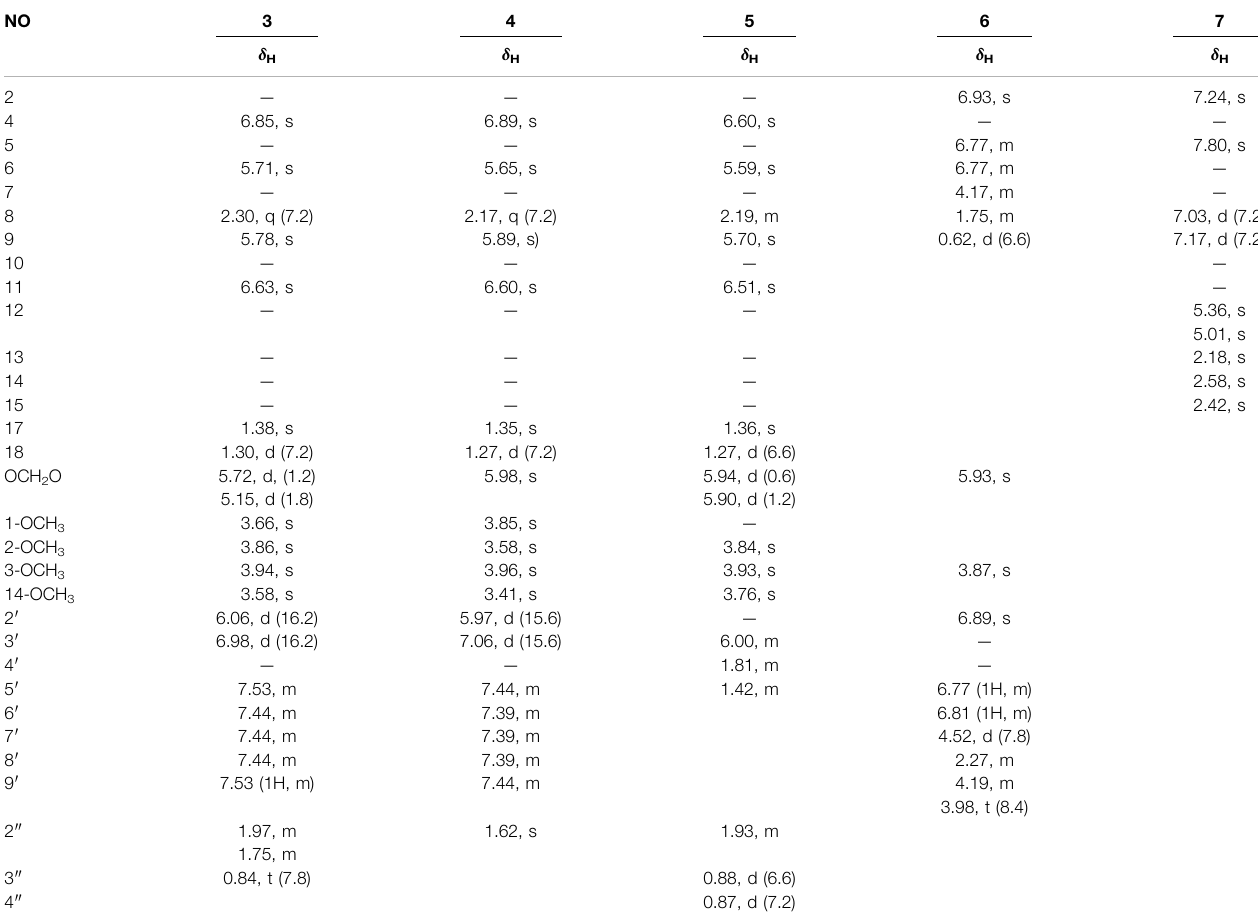
TABLE 2 | ｜ 1 H NMR (600 MHz) data of compounds 3 – 6 in CD 3 OD and 7 in CDCl 3 ( J in